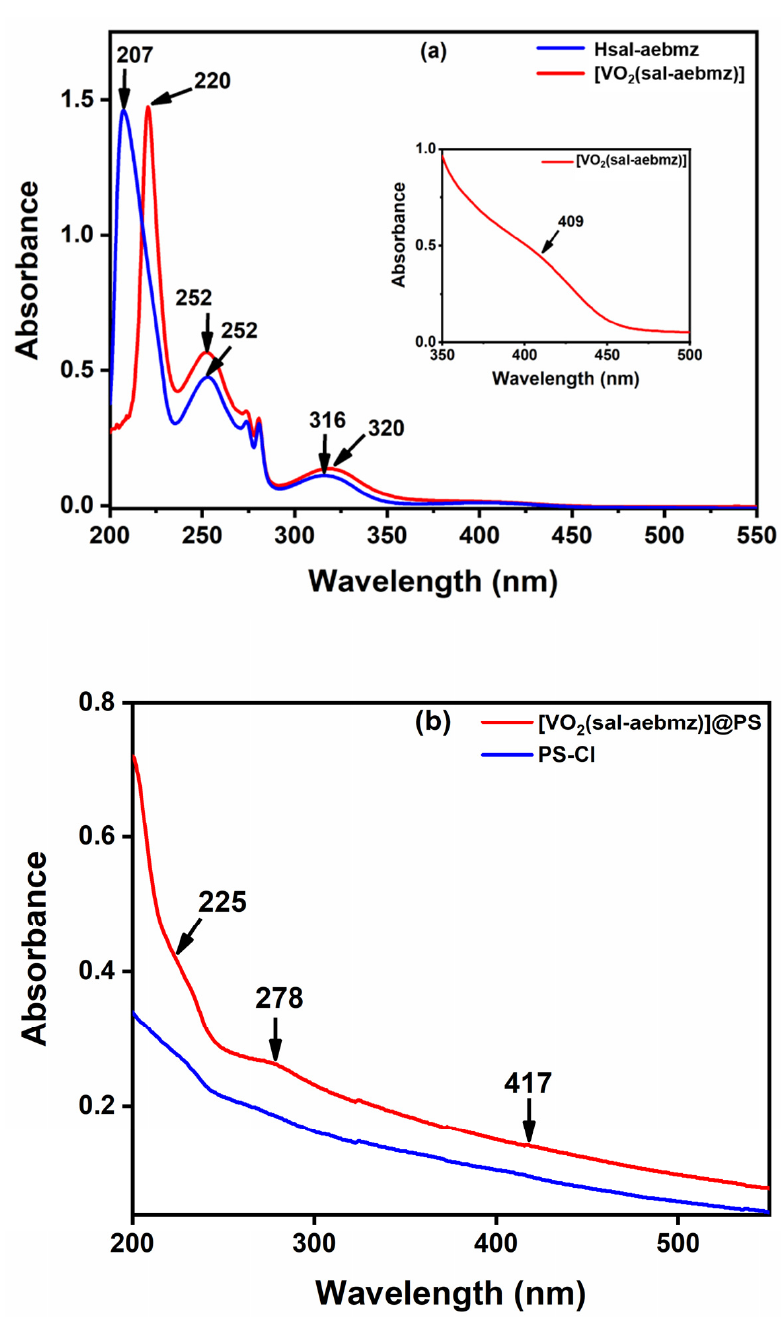
Figure 3. ( a ) UV-visible spectra of ligand Hsal-aebmz ( I ) and homogeneous complex [V V O 2 (sal- aebmz)] ( 1 ) recorded in MeOH. Inset shows a weak LMCT band of complex taken at higher concen- tration. ( b ) UV-visible spectra of PS-Cl and heterogeneous catalyst [VO 2 (sal-aebmz)]@PS ( 2 ) recorded in Nujol.